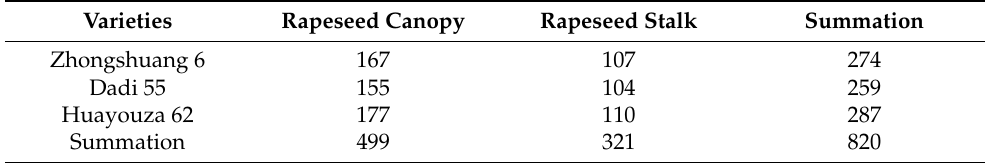
Table 1. Image data of rapeseed in mature stage.